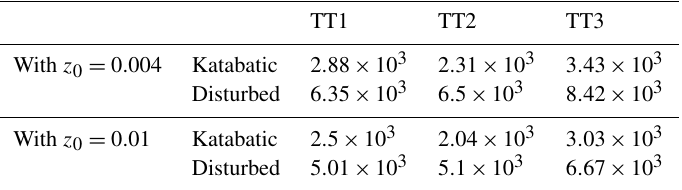
Table 1. Estimates of flux footprint area in square metres for surface roughness of z 0 = 0 . 004m and z 0 = 0 . 01m. Flux footprint areas are provided for disturbed- and katabatic-flow conditions and for the three transect stations TT1, TT2, and TT3. TT1 TT2 TT3 With z 0 = 0 . 004 Katabatic With z 0 = 0 . 01